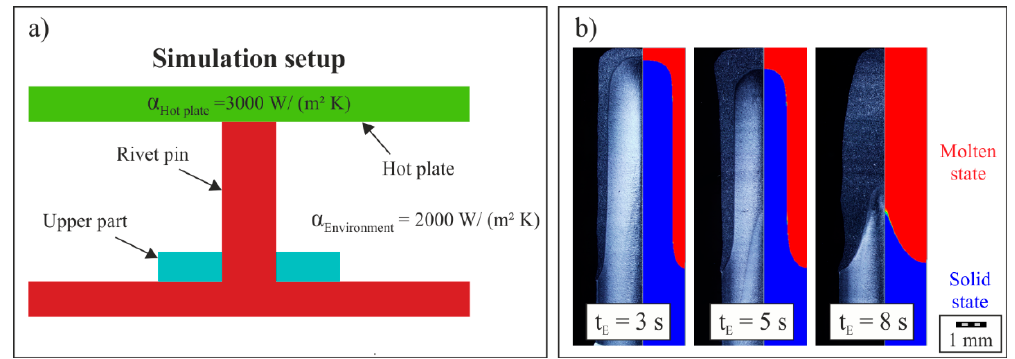
Figure 7. ( a ) Simulation setup for the calculation of the heating process and ( b ) comparison of the experimental and simulation data for different heating times t E.